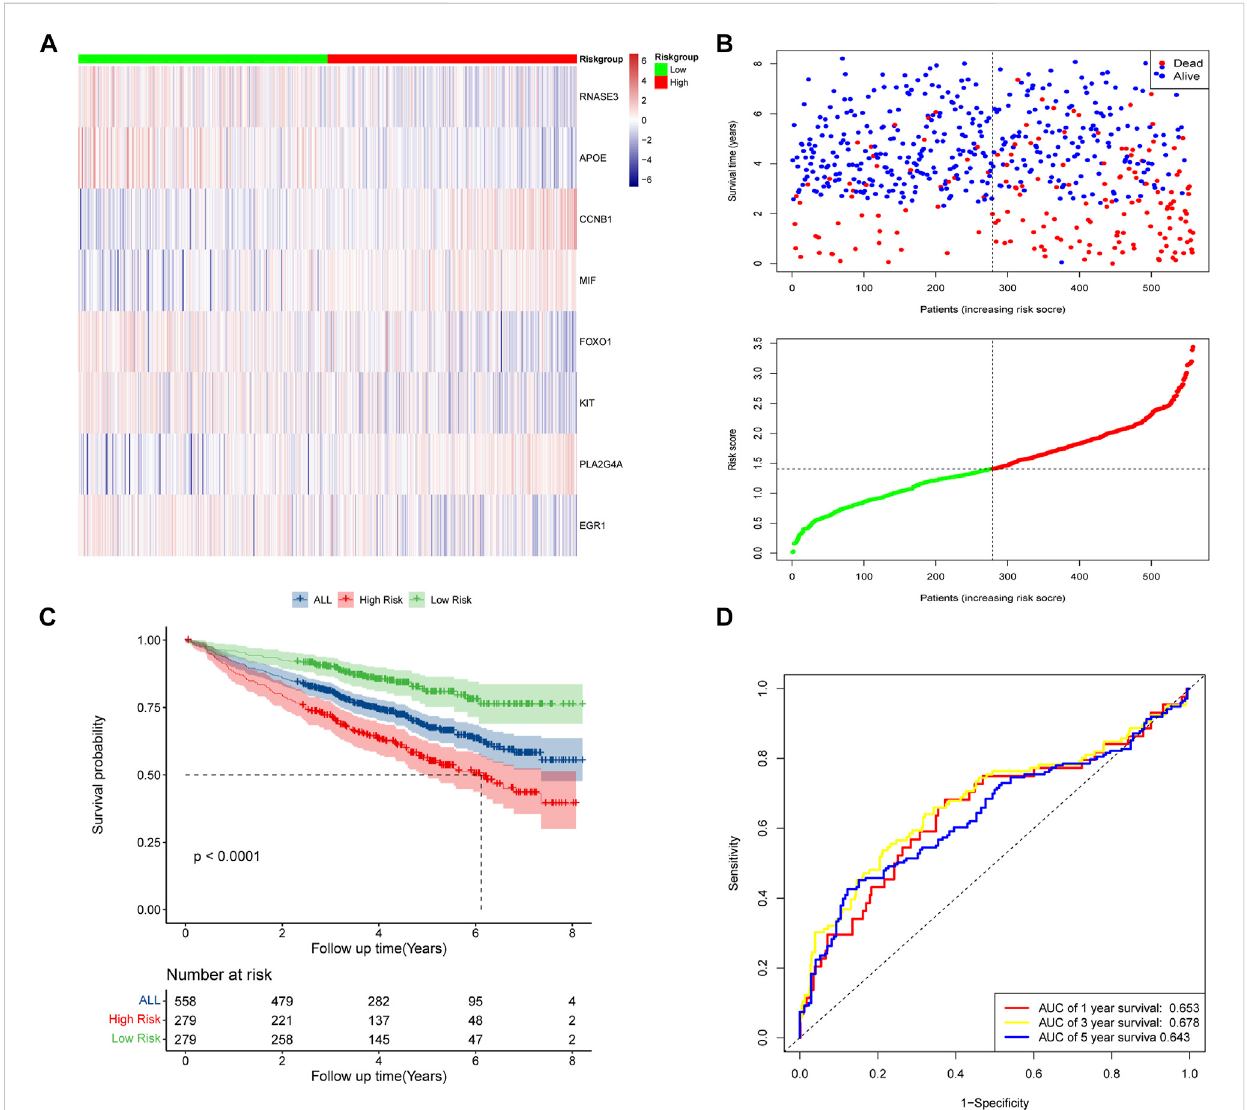
FIGURE 4 Risk score model based on eight-gene signature in GSE24080. (A) Gene expression heat map for eight prognostic genes in the high-risk and low- risk groups. (B) MM patients were divided into high-risk and low-risk groups based on the median risk score. Scatter plot of survival time and status in the high-risk and low-risk groups. (C) Kaplan – Meier curves of overall survival. (D) Assessment of the predictive ability of the model by time-dependent ROC